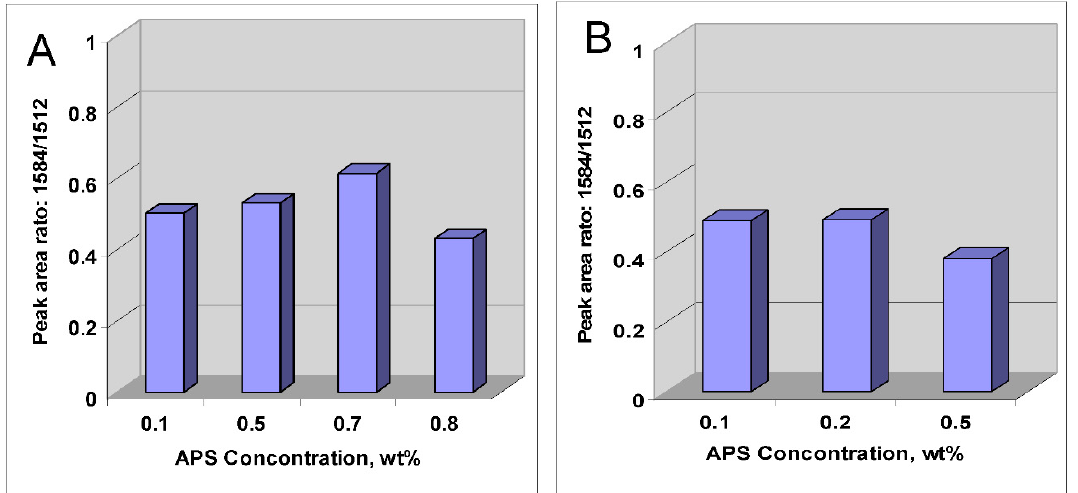
Figure 4. Quinoid/benzenoid peak area ratio for ( A ) PACN and ( B ) PANi as a function of oxidant APS concentration.